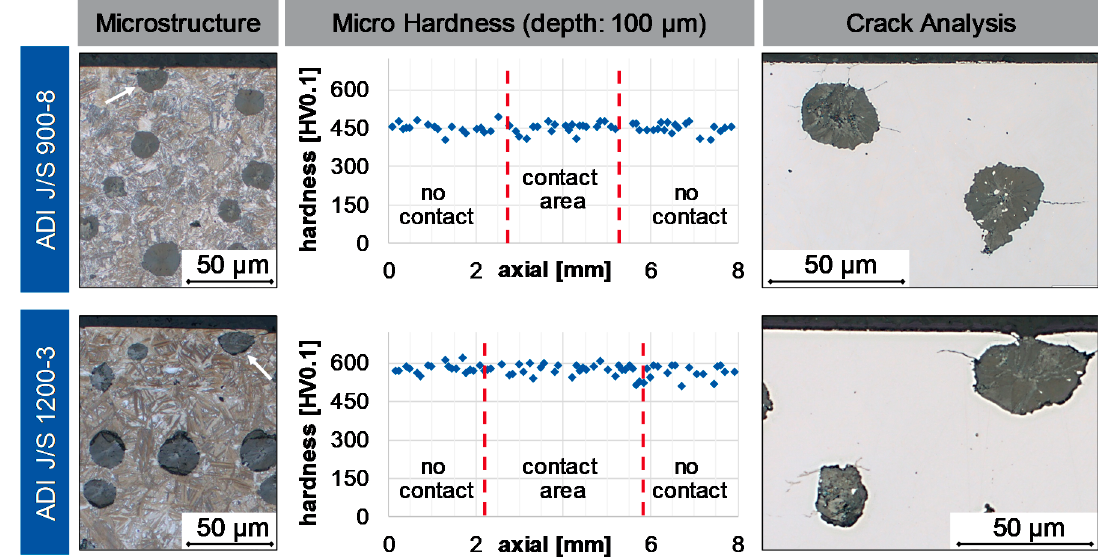
Figure 8. Analysis of the microstructure and microhardness of ADI after the test run.